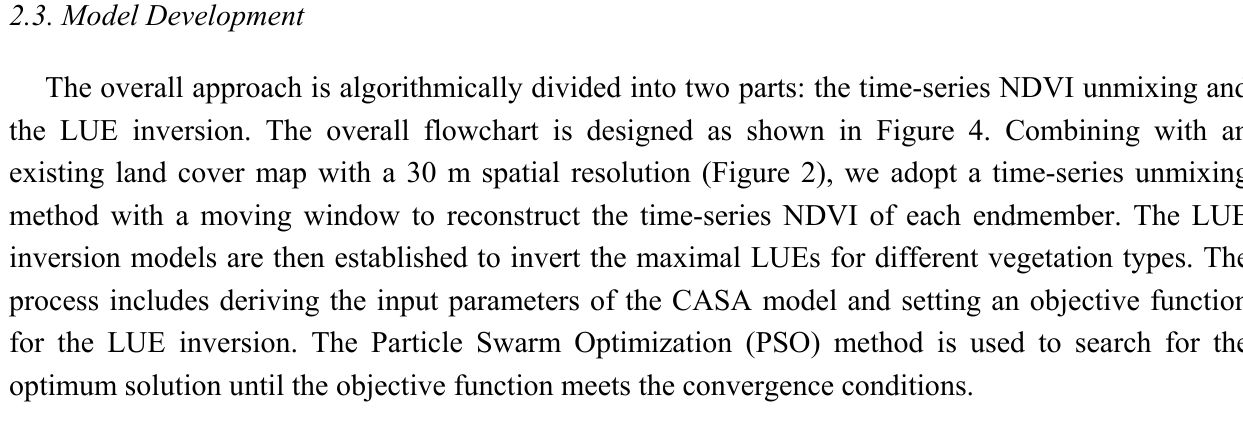
Figure 4. Overall flowchart of the approach